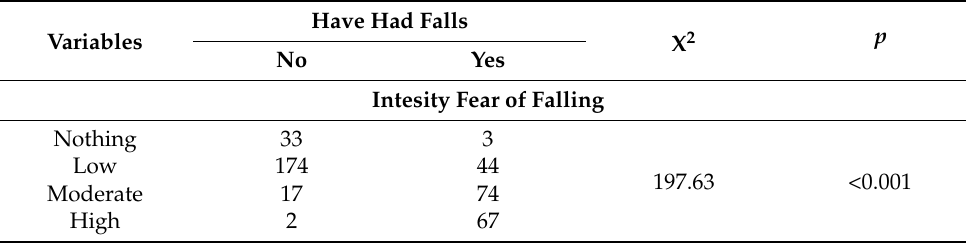
Table 8. Relationship between having had falls and the intensity of the fear of falling. Have Had Falls Variables X 2 p No Yes Intesity Fear of Falling Nothing 33 3 <0.001Low 174 44 197.63 Moderate 17 74 High 2